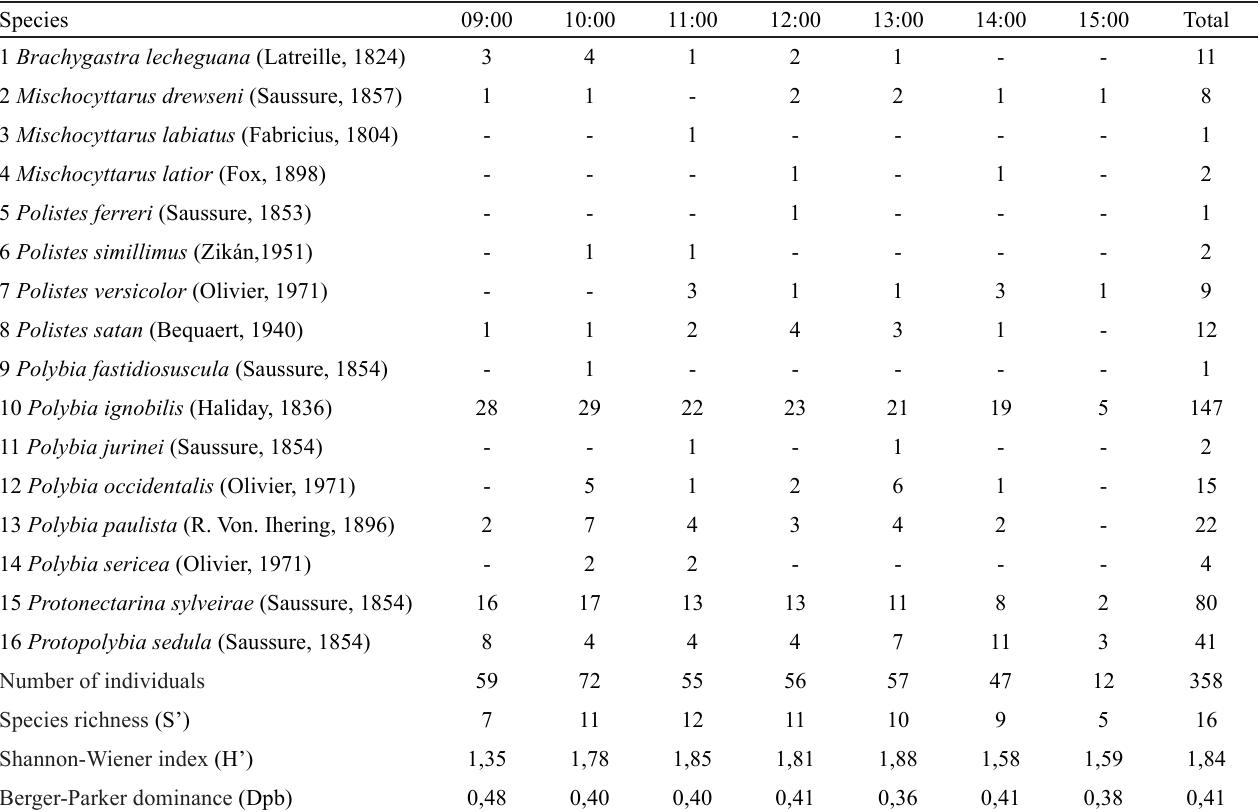
Table 1 . Number of individuals, species richness (S’), Shannon-Wiener diversity (H’) and Berger-Parker dominance (Dpb) of the collected social wasps, per hour, in twelve collections made in kale ( Brassica oleracea var. acephala ) at the Federal Institute of Education, Science and Technology of Minas Gerais (IFMG), Bambuí Campus , Minas